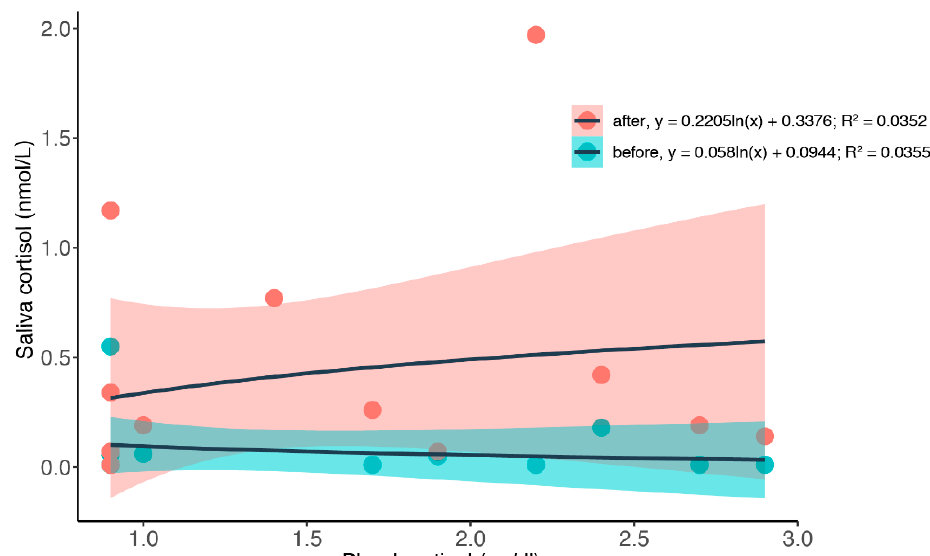
Figure A3. Correlation between blood cortisol values and saliva values during restriction. A logarithmic curve was fitted. Saliva samples were taken before (green dots) and after (red dots) the blood samples; see Figure 3 for an exemplarily sampling scheme. Three dolphins were sampled (Jenny = 9 samples; Moby = 1 sample; Anke = 1 sample; Nami = 2 samples before, 3 samples after).